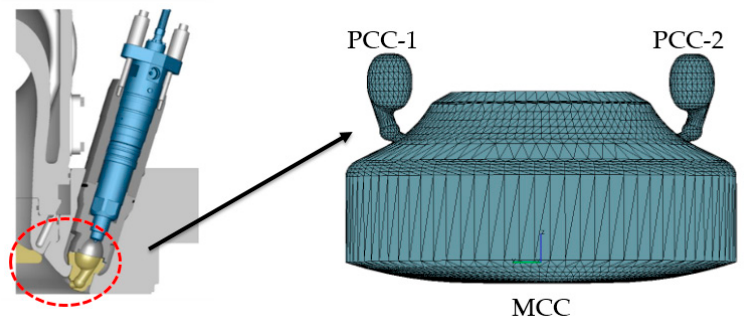
Figure 4. PCC and main combustion chamber (MCC) arrangements from a LP-DF engine.